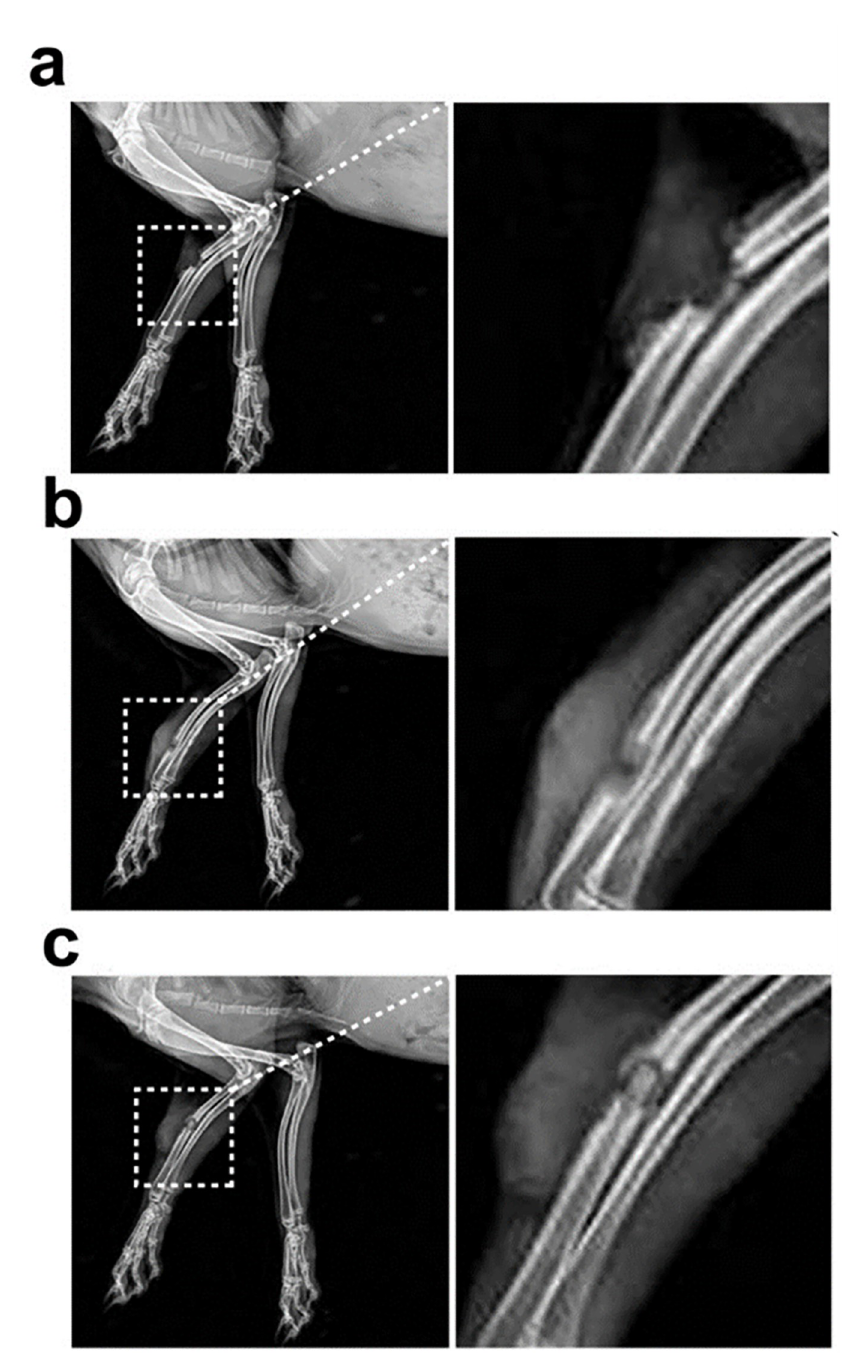
Fig 6. Radiograph results of (a) control group, (b) infected group at 4th week after modeling, and (c) experimental group on the 1st day after implantation (n = 3 rabbits per group).